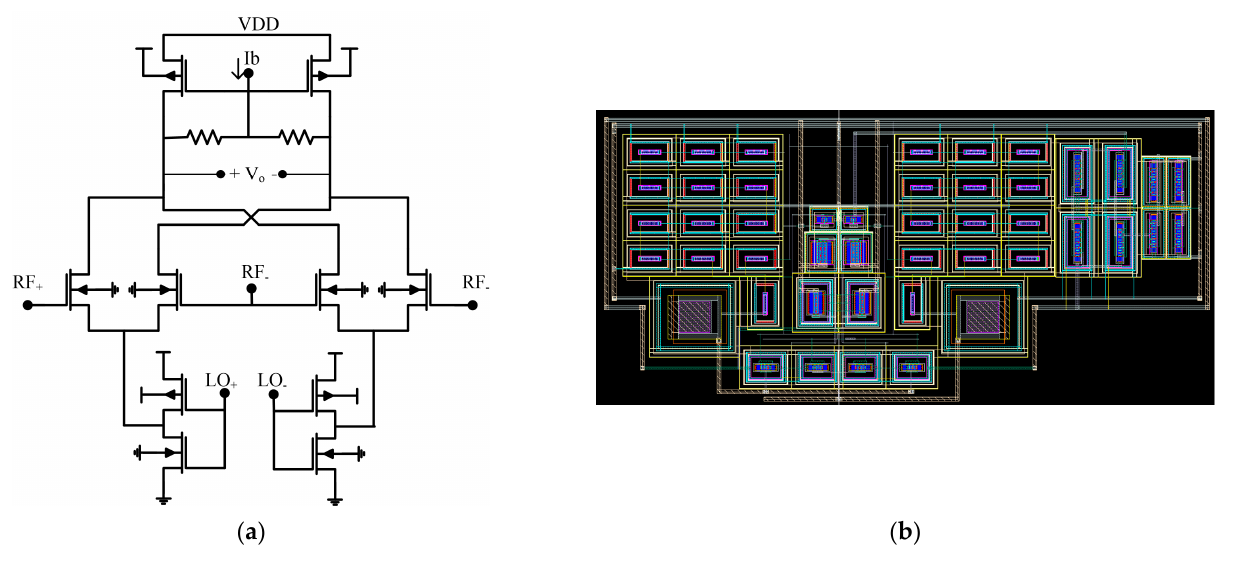
Figure 10. Mixer conversion gain versus the intermediate-frequency f IF .